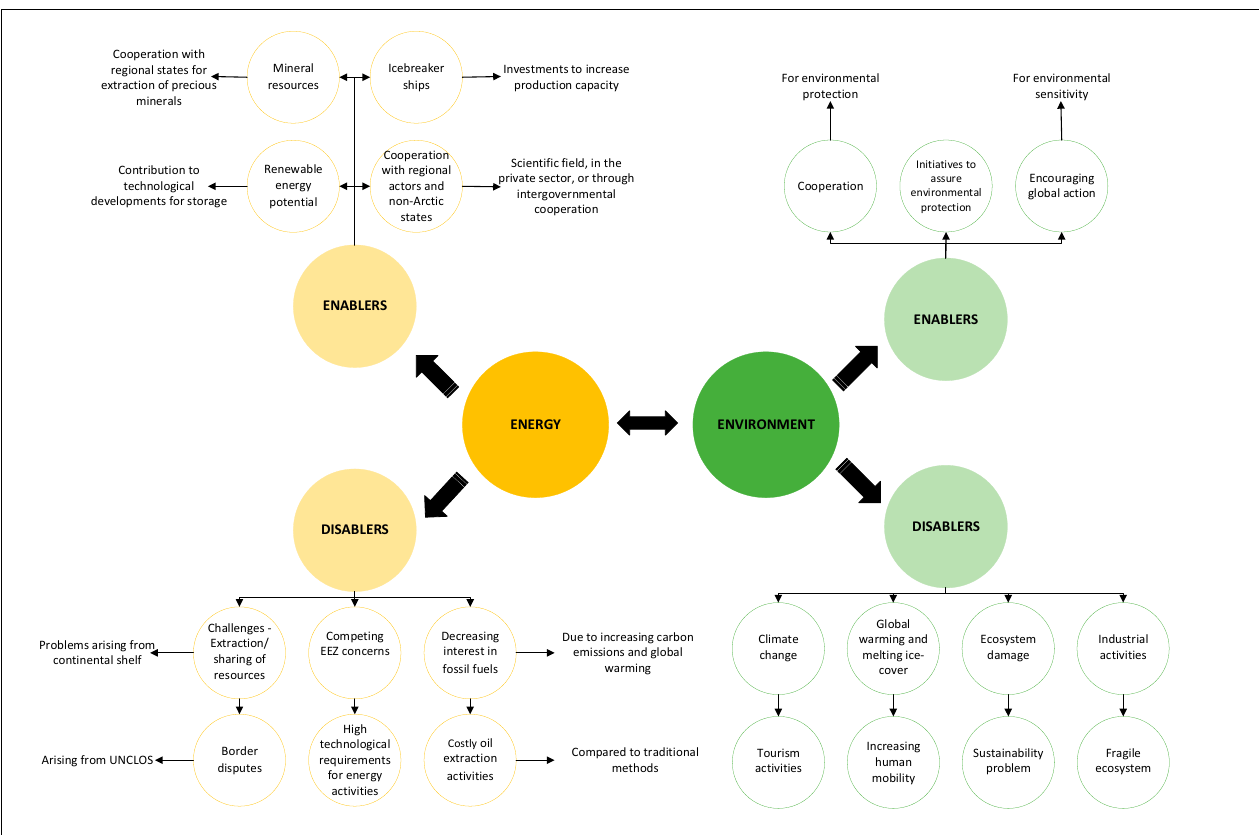
Figure 3. Results for enablers and